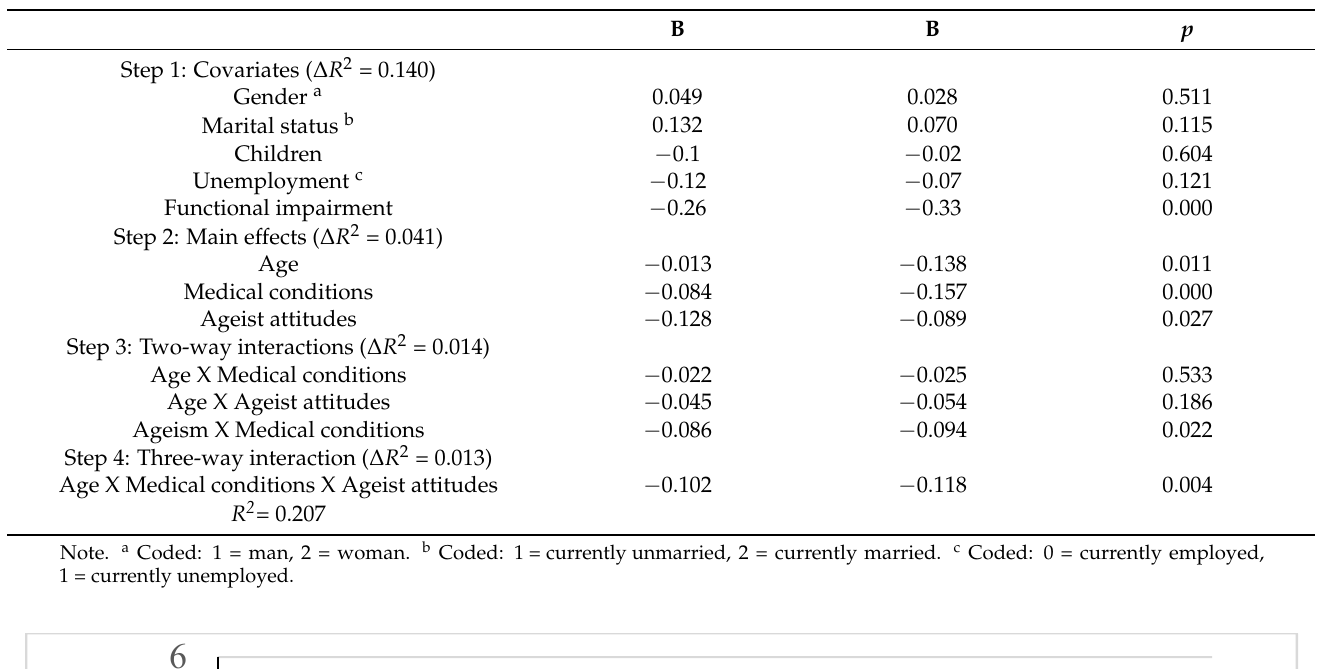
Table 2. Hierarchical linear regression predicting WTL ( n = 538).